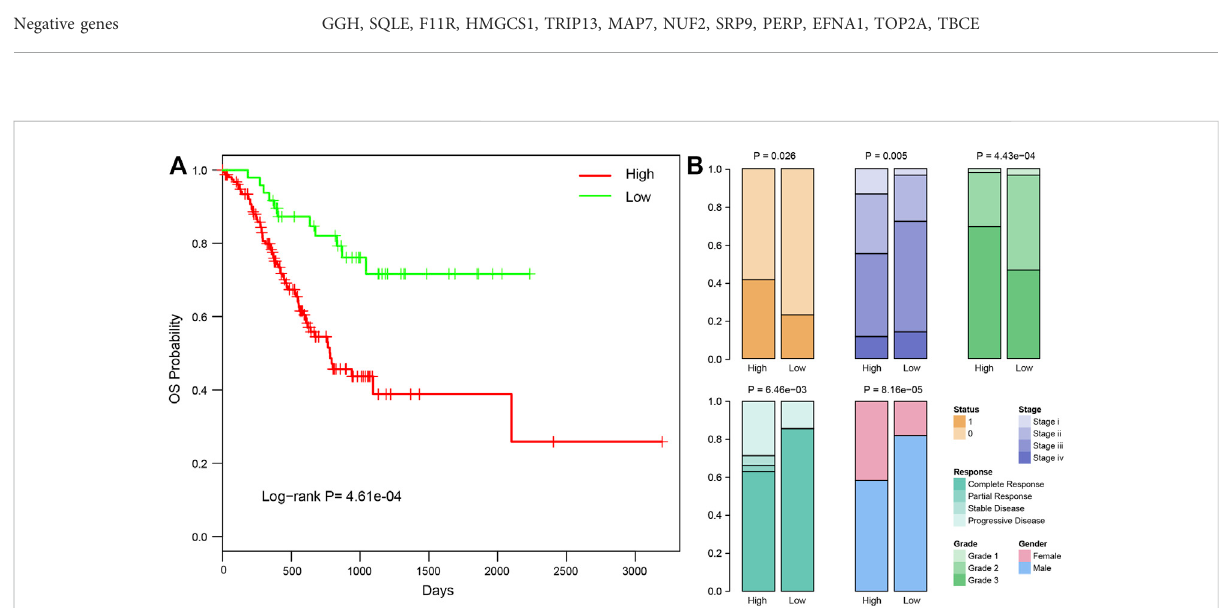
FIGURE 1 Clinical differences between samples in high and low latitudes. (A) Kaplan – Meier curves of overall survival in high and low latitudes of TCGA STAD patients. (B) Signi fi cantly different clinical factors between samples in high and low latitudes, including survival status, stage, grade, clinical response, and gender. The P and OR values were calculated using Fisher ’ s exact